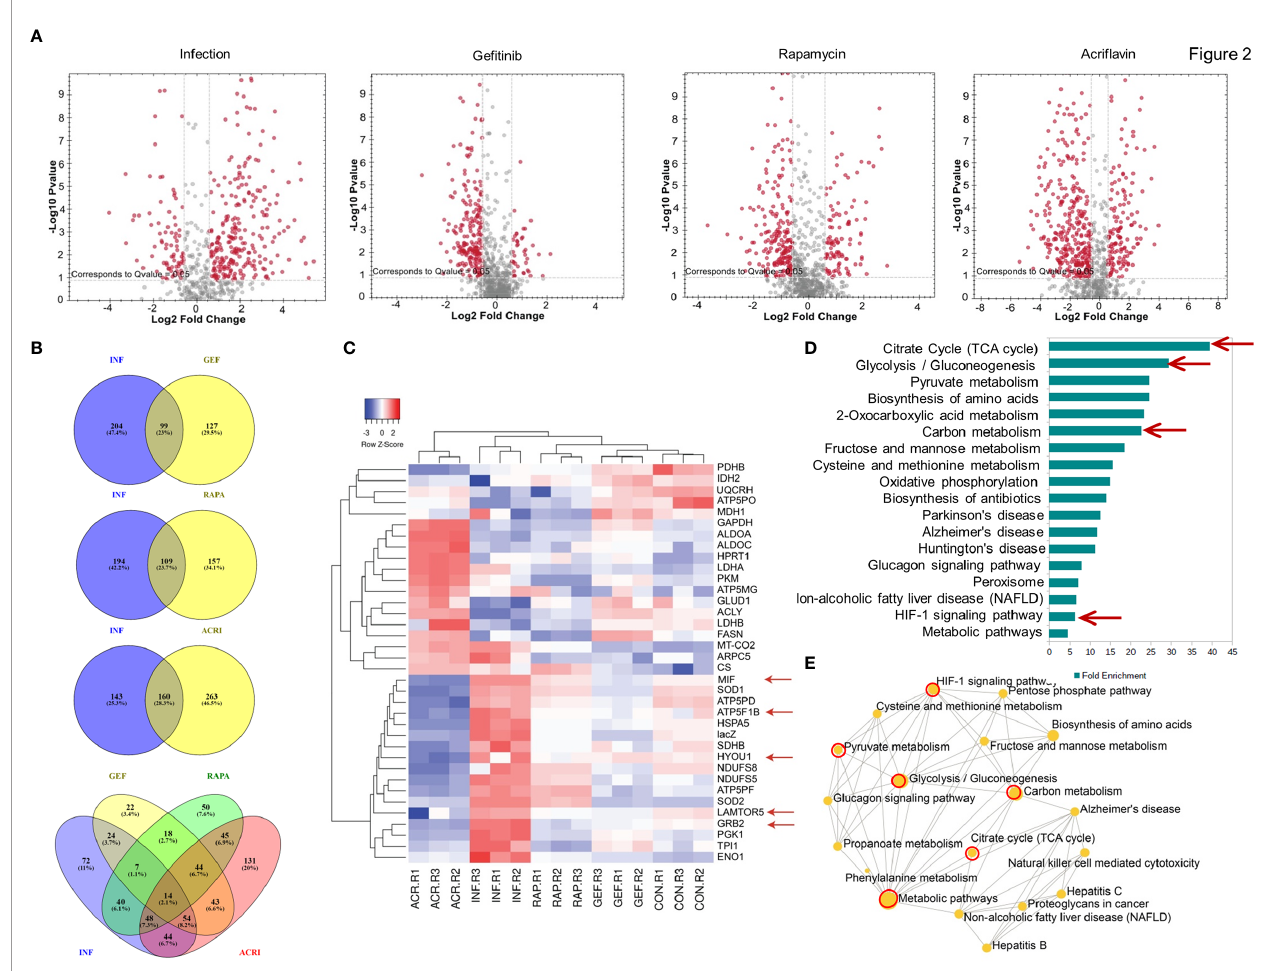
FIGURE 2 | Host proteomic analysis identi fi es pathways that support Salmonella growth within macrophages. Cell lysates obtained from S. typhi infected and Ge fi tinib, Acri fl avin or Rapamycin treated were used for proteomic pro fi ling using uninfected lysates as a control. (A) Shows volcano plot of changes in protein abundance in infection, Ge fi tinib, Rapamycin and Acri fl avin treatment. (B) Venn diagram represents a comparison of proteins between Infection and treatment groups whose p-value was <0.05 (C) Heat map indicating the relative expression of proteins, blue and red color indicates down and upregulation respectively same as green and red color indicates down and upregulation (n=3). (D) Shows signi fi cantly enriched KEGG pathway terms and their fold enrichment of 36 modulated proteins, and (E) Gene ontology term enrichment analysis. All 36 modulated proteins were analyzed using network analyst, related biological function is displayed in a circle, and circle size indicates the level of signi fi cance of enrichment; INF, Infection; GEF, Ge fi tinib; ACR, Acri fl avin; RAP, Rapamycin. Data are representative of mean ± SEM from three biological replicates and one individual technical